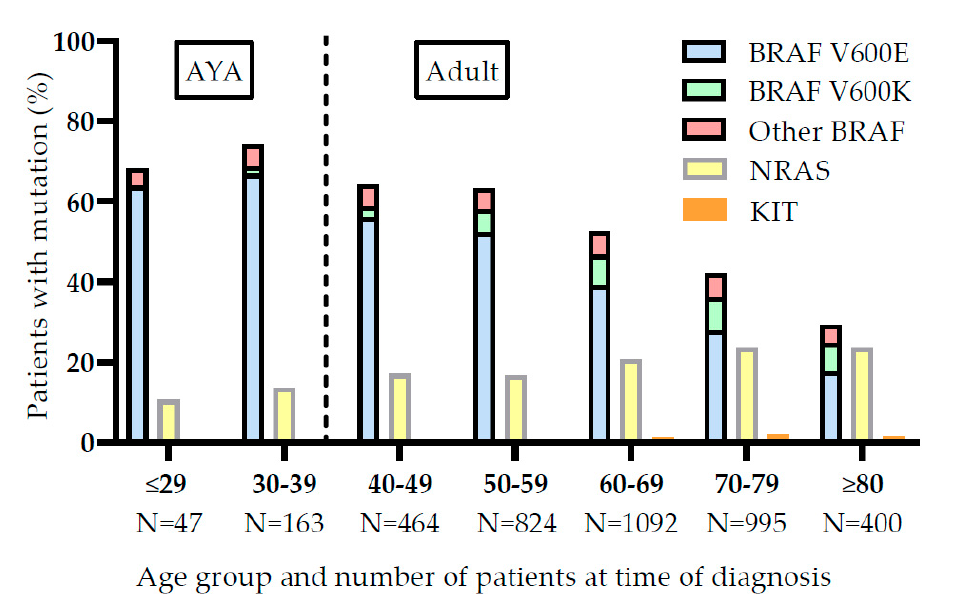
Figure 2. Incidence of BRAF, NRAS and KIT mutations in different age groups. Data on Adolescents and Young Adults (AYA) and older adults (Adult) is shown.